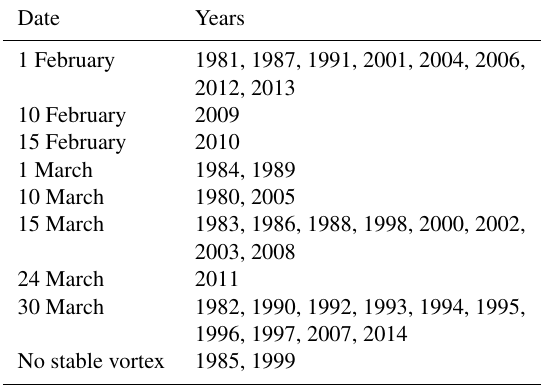
Table 4. Dates of vortex breakup for Fig.